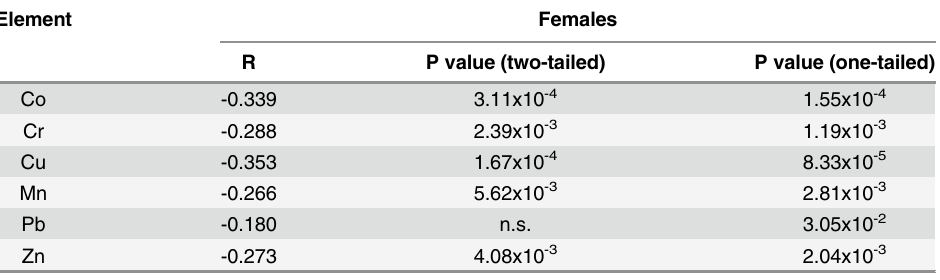
Table 5. Correlation coefficients between geochemical elements and T1D incidence rates in